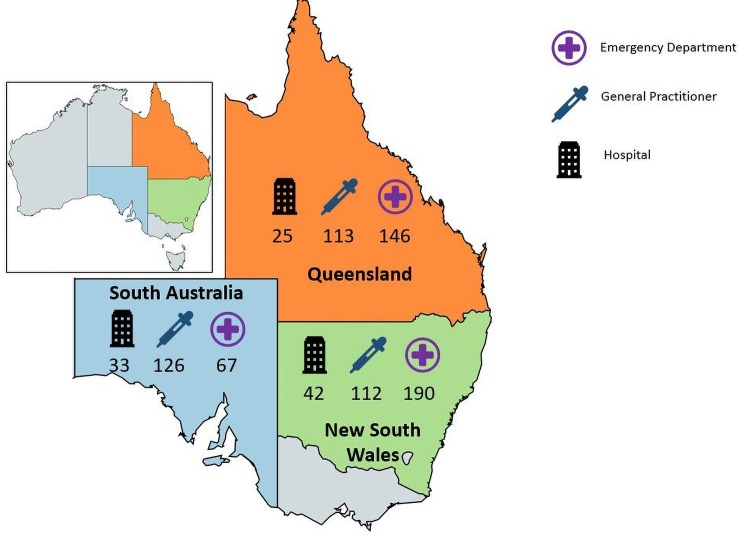
Acute Gastroenteritis assessments by state and healthcare provider type.Fig 1: total number of visits to Emergency Departments = 403; total number of admissions to hospital = 100; total number of visits to General Practitioners = 351. Total number of AGE assessments in: New South Wales = 344; Queensland = 284; and South Australia = 226. Total number of visits assessed for care of AGE in sampling frame = 854. [Adapted from https://mapchart.net/, CC BY-SA 4.0].